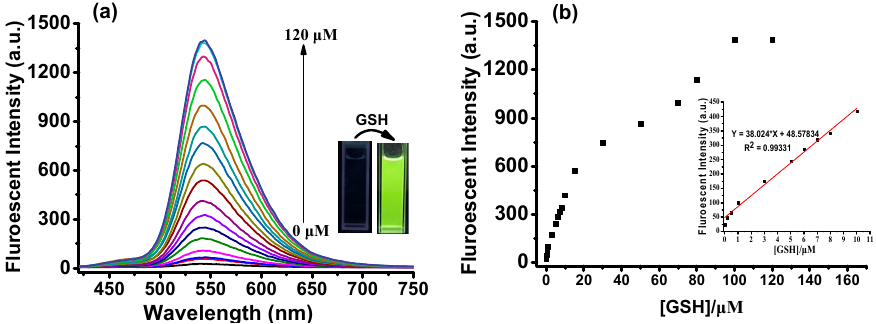
Figure 2. ( a ) Fluorescence response of PBD (10 µ M) upon the addition of GSH (0–120 µ M) in EtOH-PBS bu ff er (10 mM, pH 7.4, 4:6, v / v ). Inset: Fluorescence images of PBD (10 µ M) in the absence (left) and presence (right) of GSH under a 365 nm UV lamp. ( b ) Fluorescence intensity of PDB (10 µ M) at 540 nm as a function of GSH concentration (0–120 µ M) in EtOH-PBS bu ff er (10 mM, pH 7.4, 4:6, v:v ). Inset: the linear relationship between fluorescence intensity and GSH at low